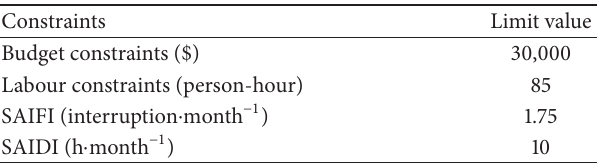
Table 4: Maintenance and system operation constraints in one period.